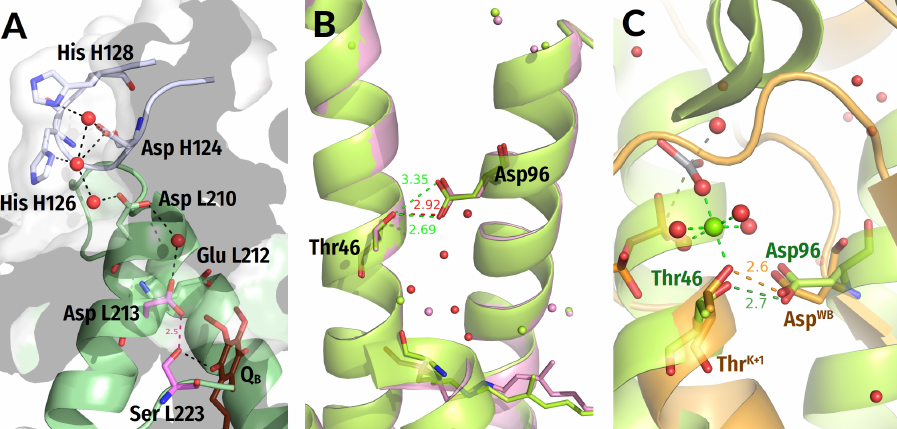
Figure 9. Proton traps in the photochemical reaction center and bacteriorhodopsin as compared with the Thr K+1 -Asp WB pair of P-loop NTPase. Distances are given in ångströms. ( A ) A high-pK proton trap in the photosynthetic reaction center (PRC) from Rhodobacter sphaeroides. Shown is the PRC in the charge-separated state (PDB ID 1DV3 [215]). Here, a proton path connects the protein surface with the buried binding site of the secondary ubiquinone acceptor Q B . The proton is translocated over more than 20 Å via amino acid residues of the two PRC subunits, L and H. The proton pathway begins at the two His residues on the surface (His-H126 and His-H128); they are thought to have pK values of about 7.0 and to harvest protons that are ejected onto the photosynthetic membrane surface by the ATP synthase. From these histidine residues, the proton goes, via water-bridged carboxyl groups of Asp H-124 and Asp-L210, to the Q B -binding pocket. Proton transfer from the surface